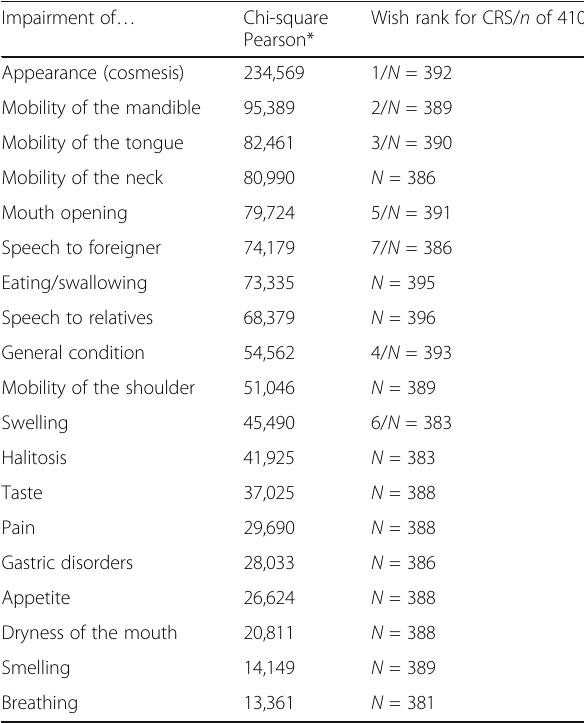
Table 7 Parameters affecting the wish for further CRS